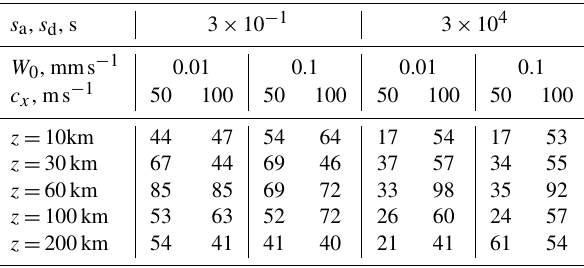
can propagate up to the upper atmosphere. Slow decay rates shown in Table 1 may be caused by partial reflections of the wave energy resulting in vertically standing AGW modes (see Sect.